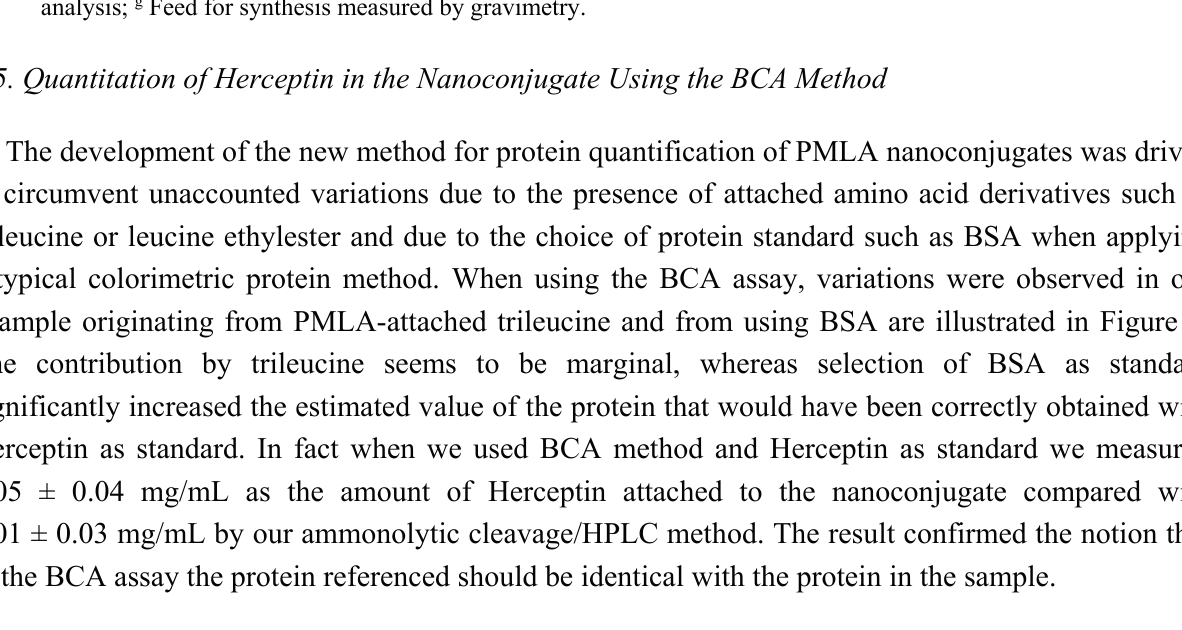
a Concentration; b total content; and c recovery determined by ammonolysis and SEC-HPLC analysis; d AON concentration; e total content; and f recovery determined by reductive cleavage and reverse phase HPLC analysis; g Feed for synthesis measured by